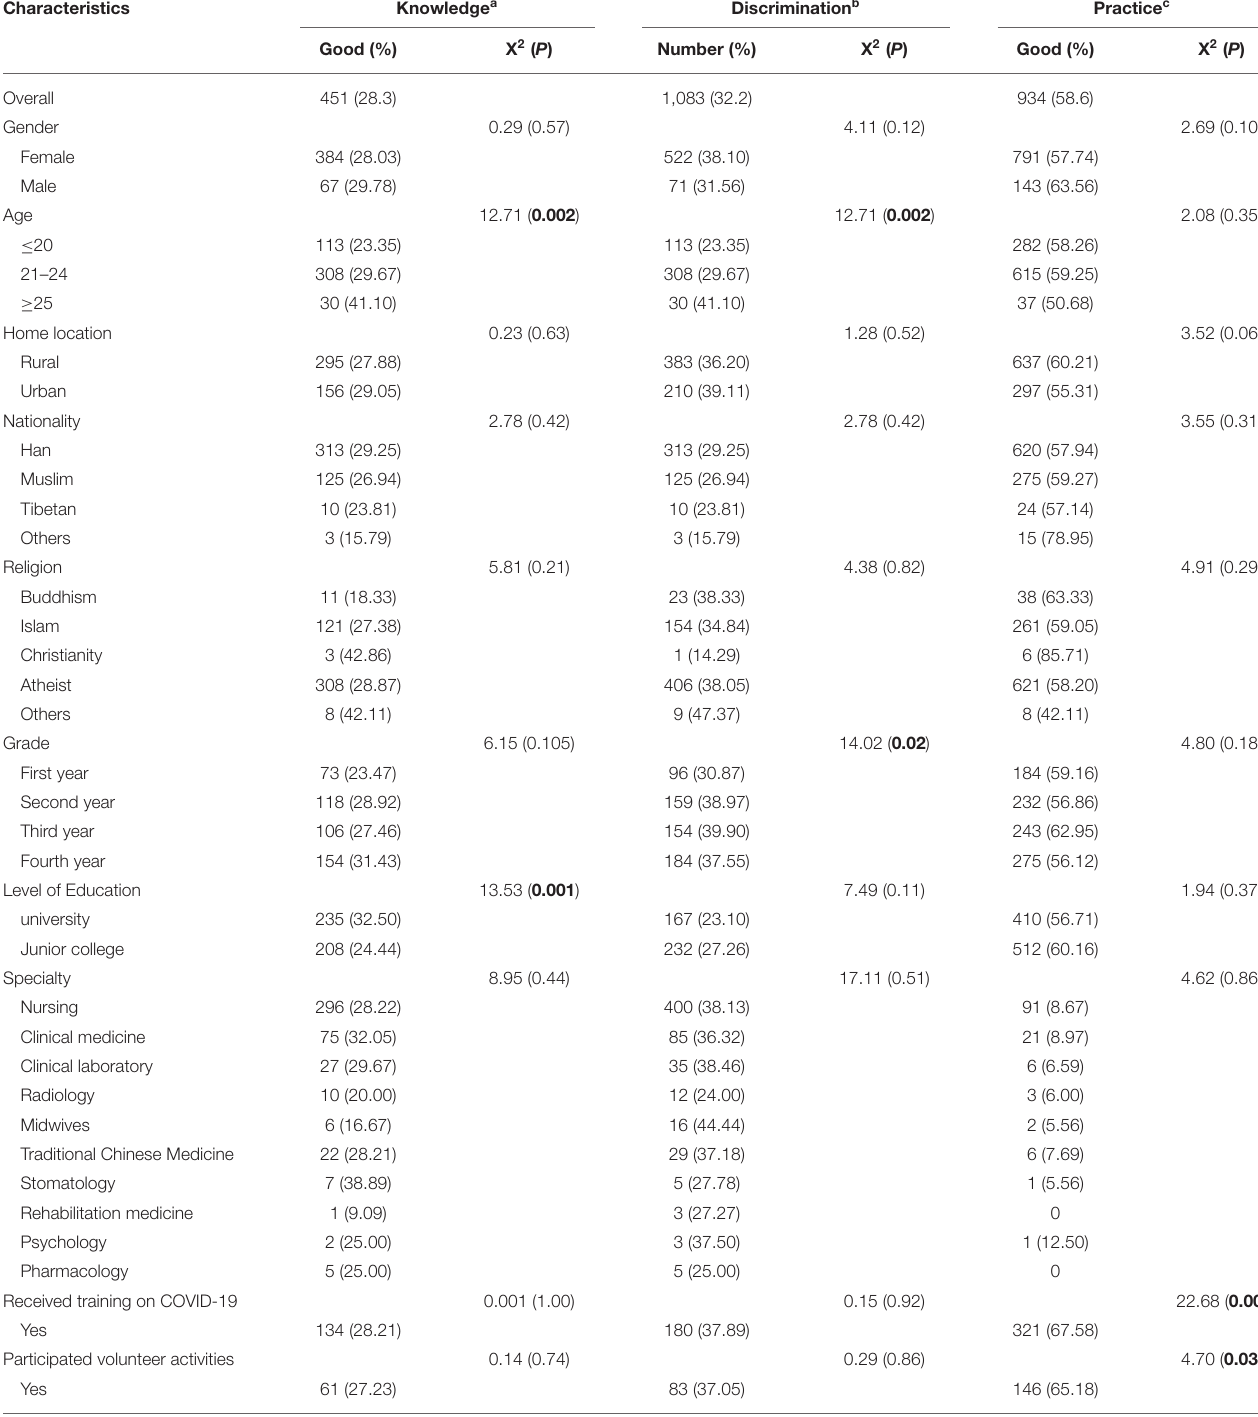
TABLE 2 | Differences in knowledge, discrimination, and practice by